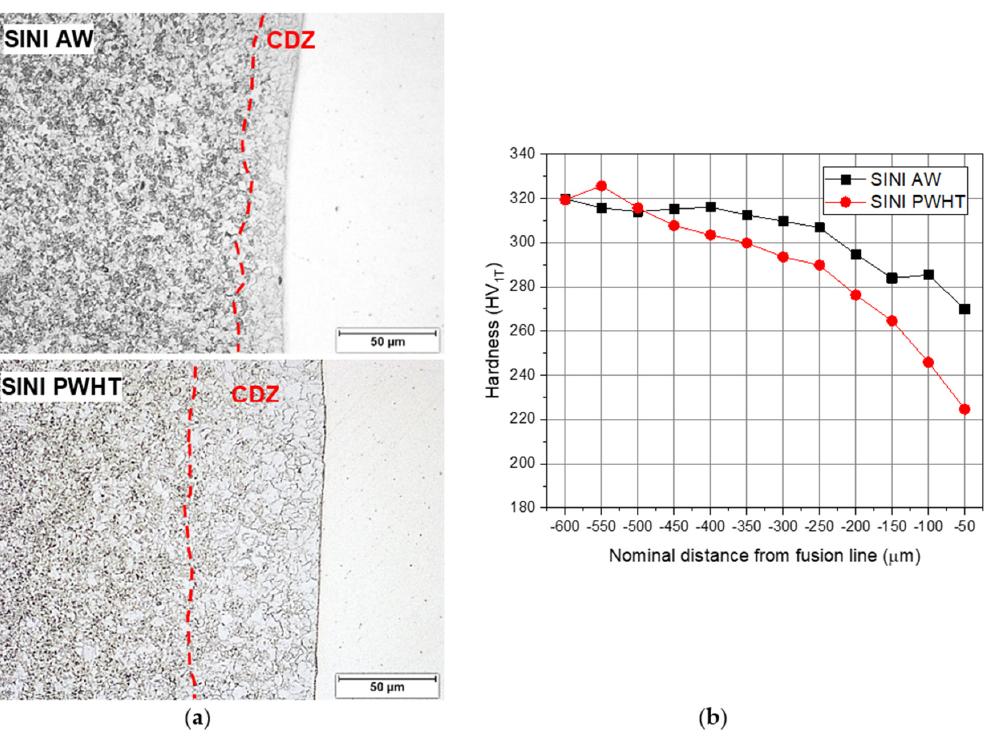
Figure 8. ( a ) Optical images of the SA 508/Alloy 52 weld metal interface in SINI AW and SINI PWHT, with ( b ) the corresponding hardness profiles, showing the widening of the CDZ upon PWHT.